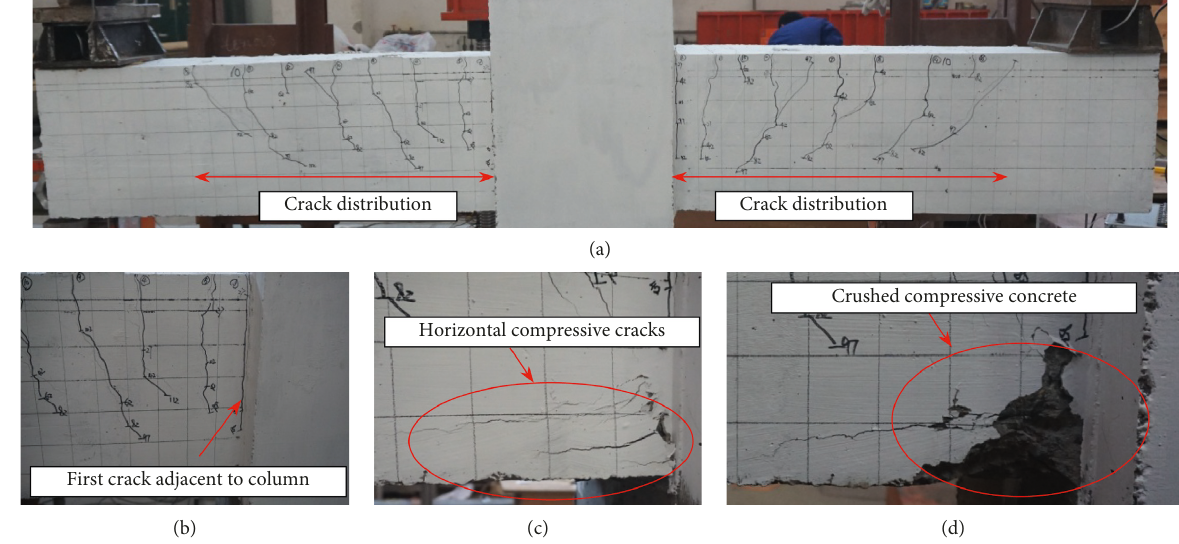
Figure 7: Photographs from the experimental study. (a) Crack distribution in the shear span. (b) First crack at the section adjacent to the beam-column connection. (c) Horizontal compressive cracks developed at the compressive zone. (d) Compressive concrete was obviously